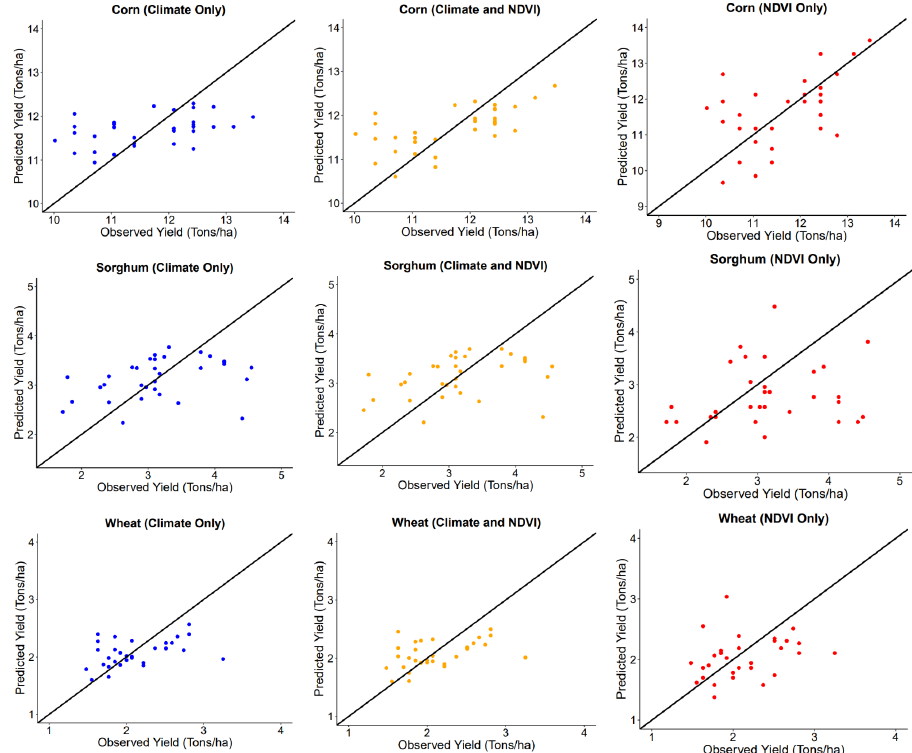
Figure 10. The scatter plot of observed and predicted corn, sorghum, and wheat yields resulting from the best climate only, climate and NDVI, and NDVI only models (1984 to 2016). from the best climate only, climate and NDVI, and NDVI only models (1984 to